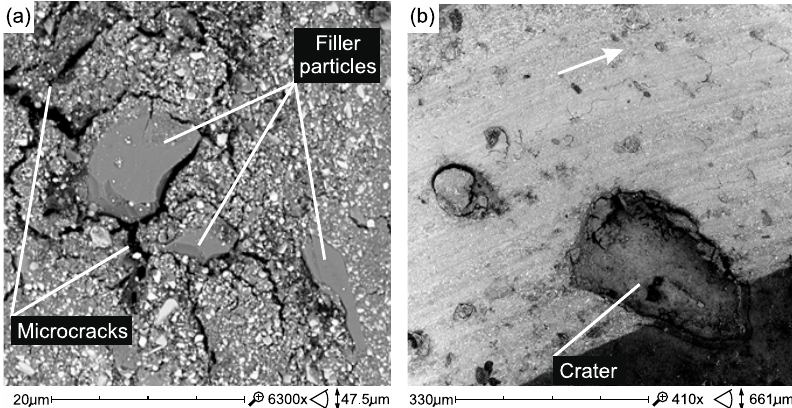
Figure 10. Crushing of large ceramic filler microparticles ( a ) and torn large particles / agglomerates of the filler in wear scar (pitting wear) Ex-mhyb(P) ( b ). Direction of sliding marked by an arrow.